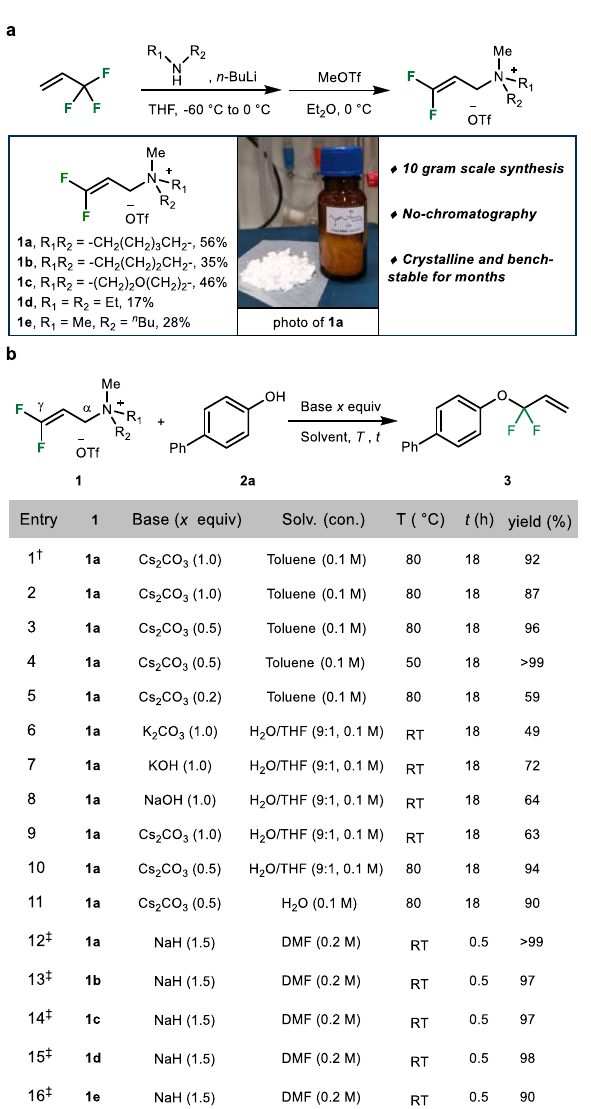
Fig. 2 Reagent synthesis and model reaction. a Two-step synthesis procedure for the preparation of di fl uorinated allyl ammonium salts 1a – 1e